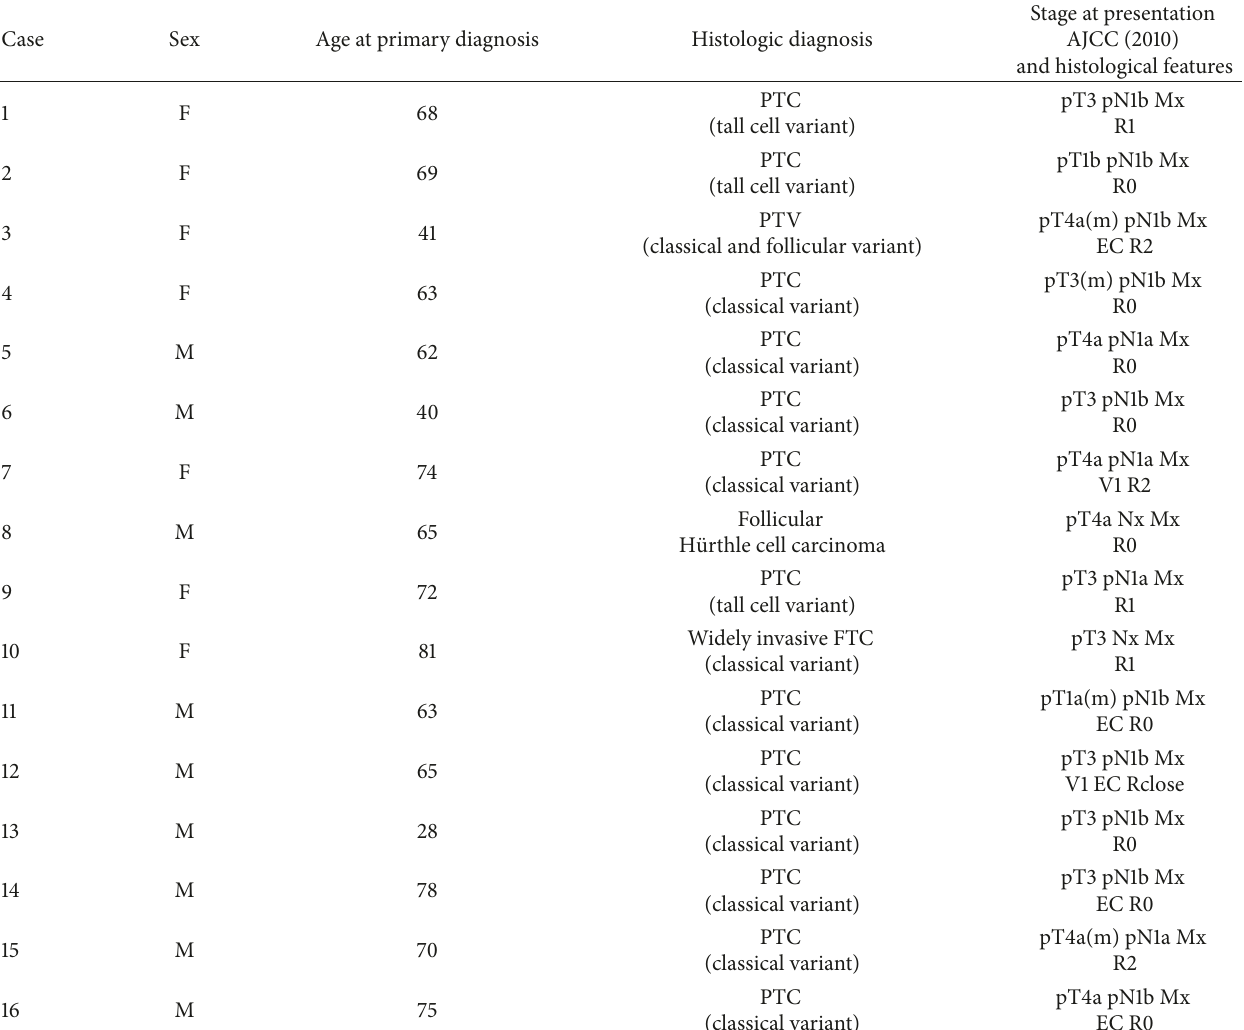
Table 1: Patients and clinicopathologic